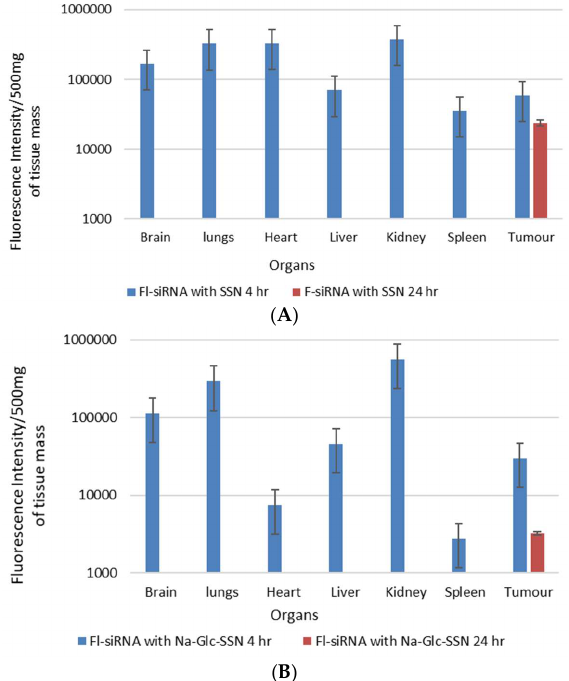
Figure 16. In vivo biodistribution of AF-488–labelled siRNA in nude mice bearing a xenografted 4T1 tumor 4 h and 24 h after intravenous injection of siRNA-loaded nanoparticles; ( A ). SSNs and ( B ). Na- Glc-SSNs. Each bar represents the mean ± SEM based on three mice per groups in all